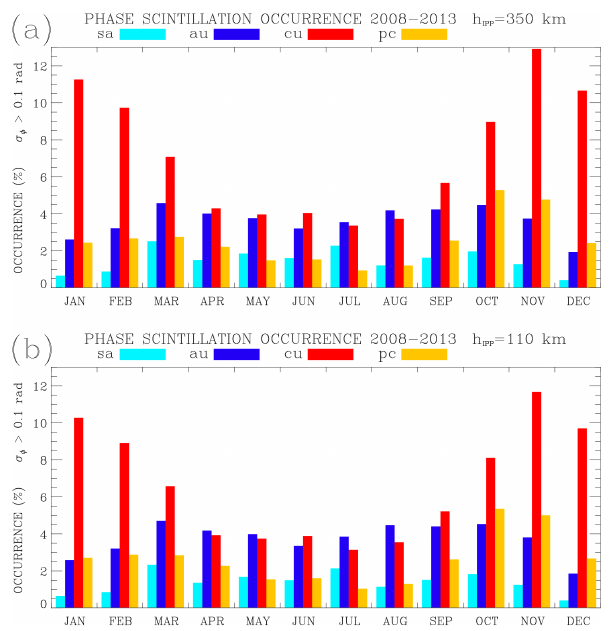
Figure 6. Monthly variation of phase scintillation occurrence in cu, au, pc and sa sectors for ( a ) h IPP = 350km and ( b ) h IPP =